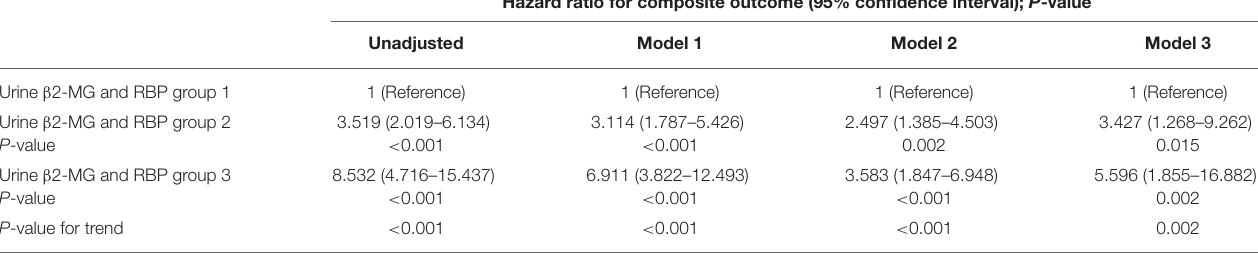
TABLE 4 | Association of the combination of baseline urine β 2-MG and RBP with the composite renal outcome. Hazard ratio for composite outcome (95% confidence interval); P